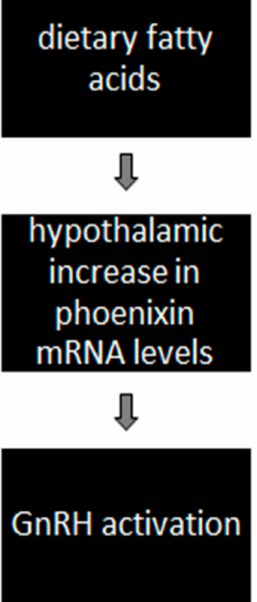
Figure 2. Diet-induced phoenixin mRNA upregulation and GnRH